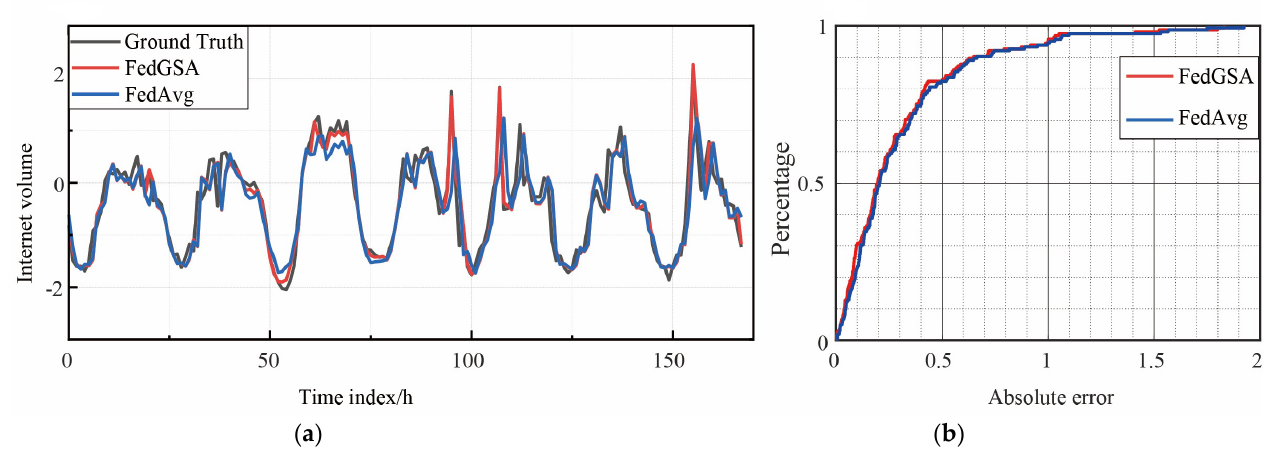
Figure 7. ( a ) describes the traffic comparison on the Milano dataset; ( b ) describes the results of the cumulative distribution function (CDF) on the Milano dataset.